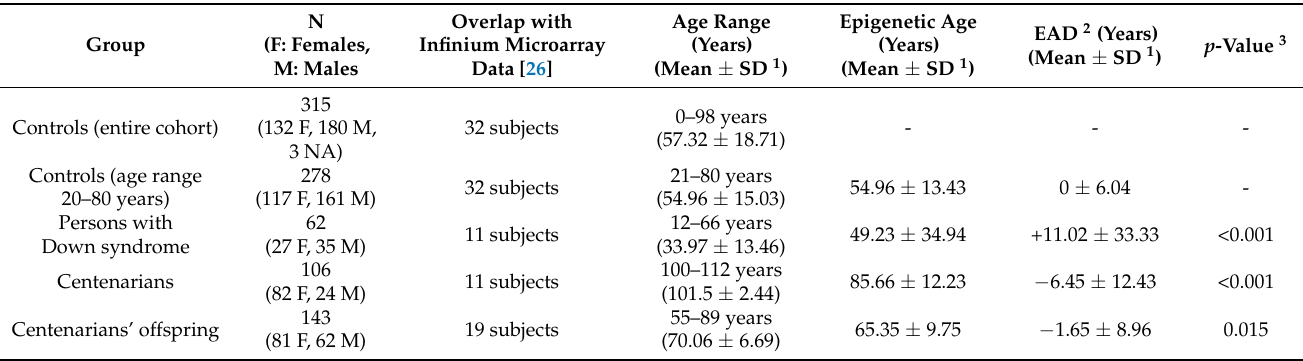
Table 1. Datasets used for developing and validating the targeted epigenetic clock.